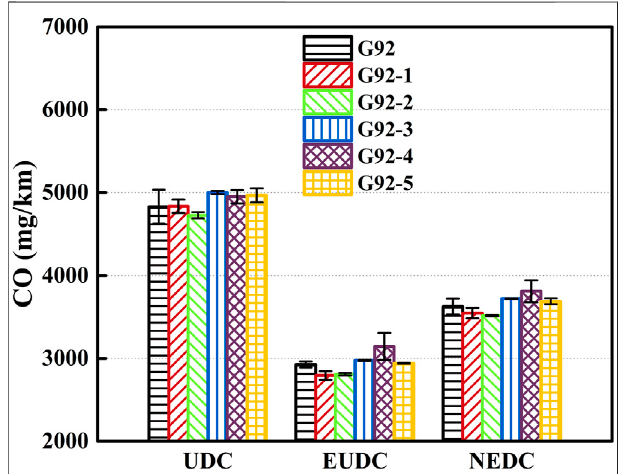
FIGURE 5 | The CO emission of the vehicle fueled with different test